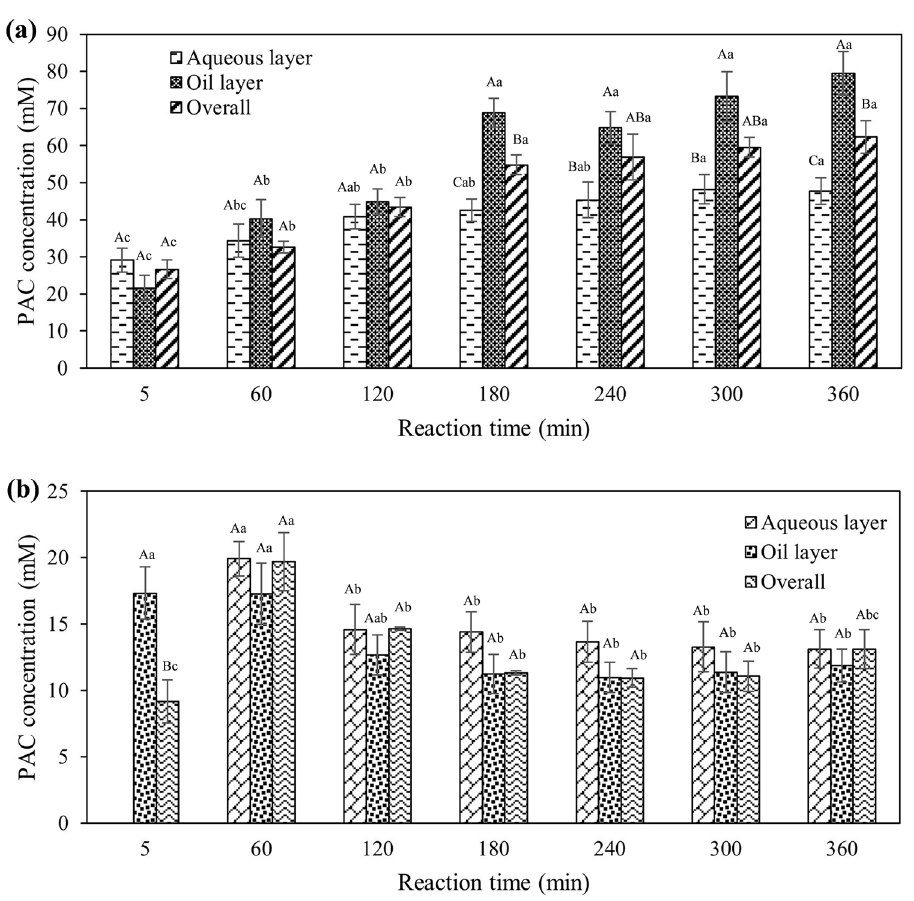
Figure 4. Biotransformation of phenylacetylcarbinol (PAC) in a two-layer system. ( a ) PAC concentration when whole cells biomass of C. tropicalis was used as biocatalyst; ( b ) PAC concentration when partially purified PDC was used as a biocatalyst. Error bars indicate the standard error from the mean (n = 3). Means with different uppercase alphabets indicated a significant difference (p ≤ 0.05) between aqueous, oil phase and overall, of the same reaction time. Means with different lowercase alphabets indicated a significant difference (p ≤ 0.05) between time intervals of the respective